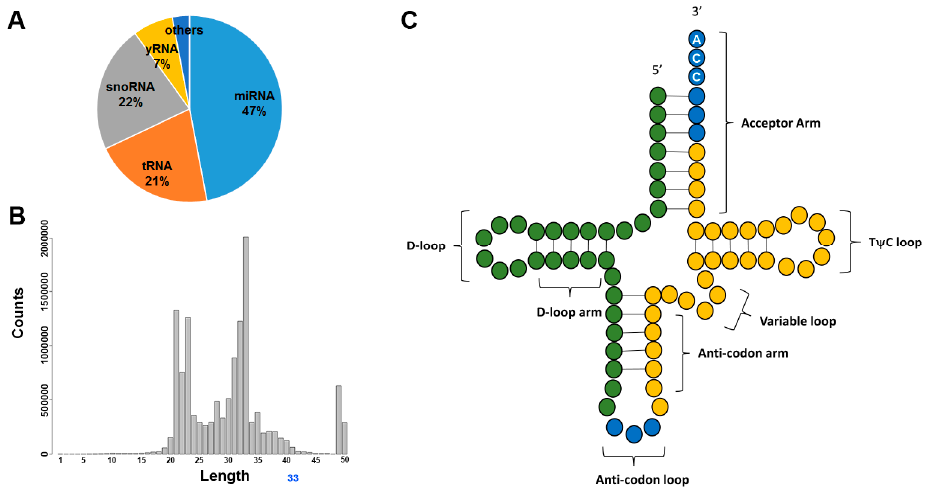
Figure 5. Small RNA (sRNA) sequencing. ( A ) The rough distribution of sRNA types in a sequencing sample. The distribution varies based on sample type; ( B ) example read length histogram after trimming adaptor sequences. Generally, two peaks (at 22 nucleotides for miRNA and at 33 nucleotides for transfer RNA (tRNA)) can be observed; ( C ) mature tRNA figure. The commonly captured fragments of tRNAs, forming the peaks in the length histogram, are the green and yellow segments of the tRNA.